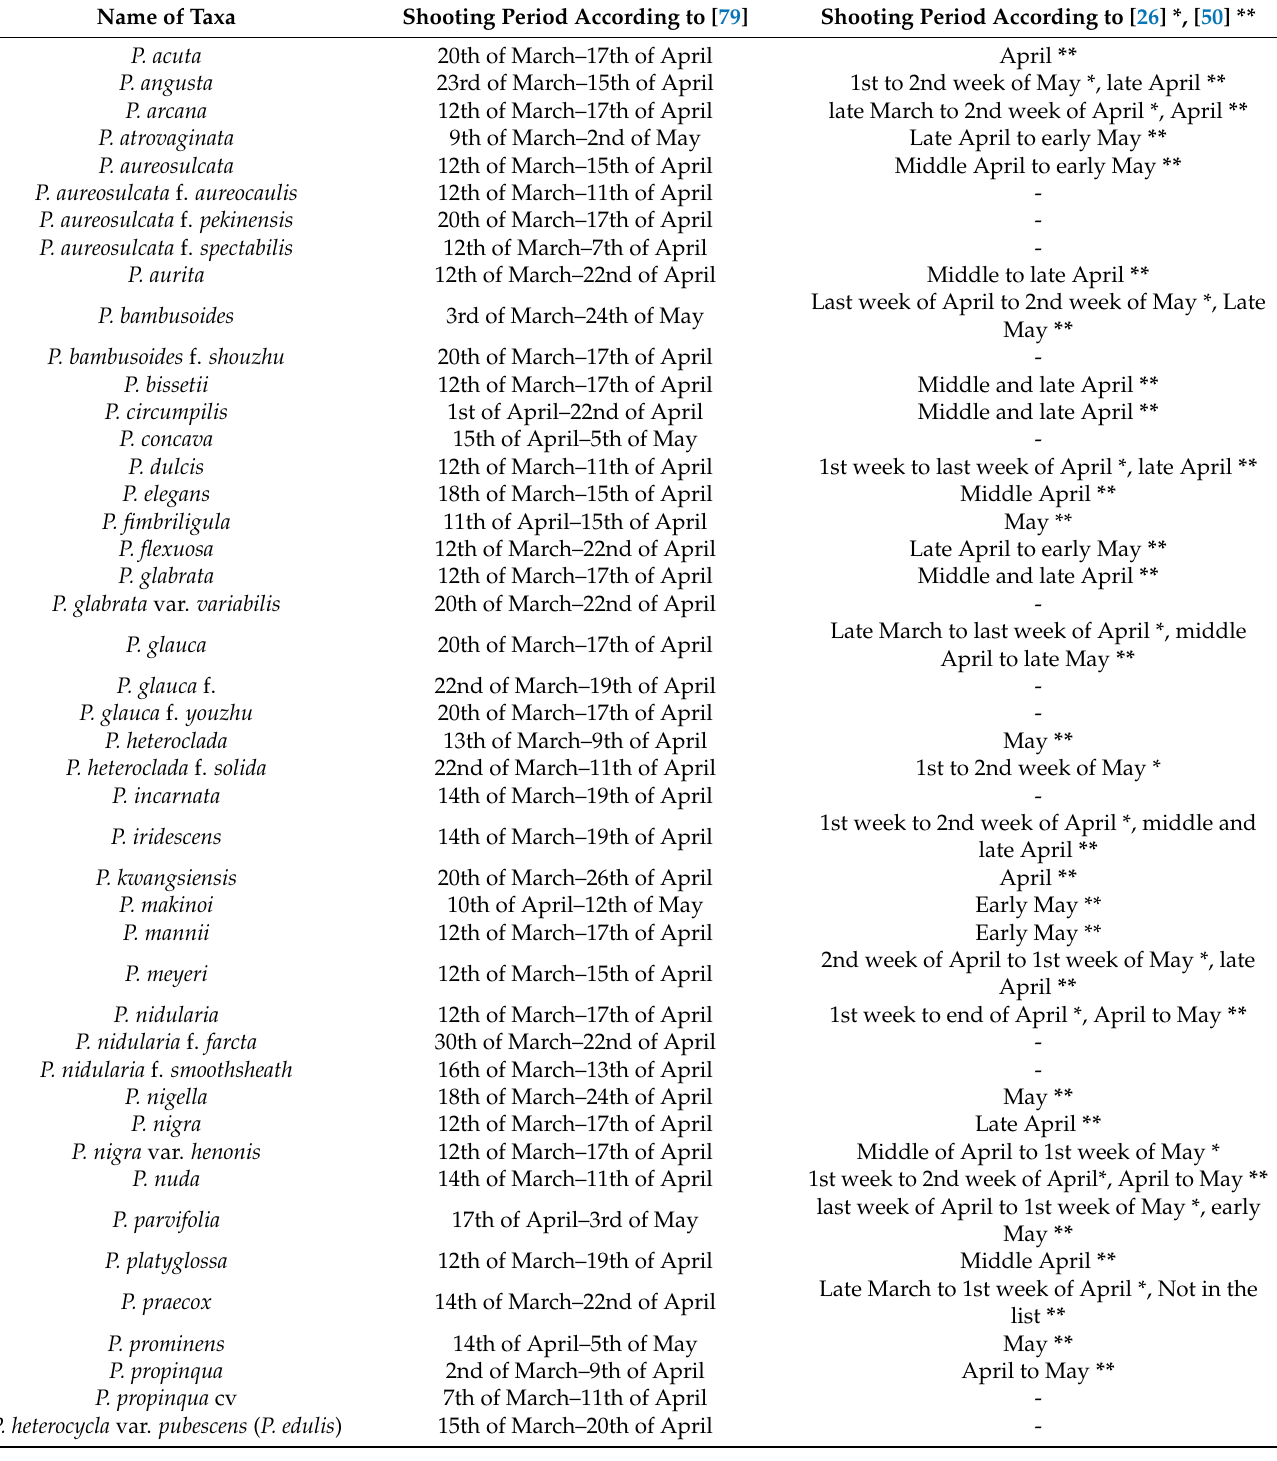
Table 2. Summary of shooting period of introduced Phyllostachys spp. in China [26,50,79]. * refers